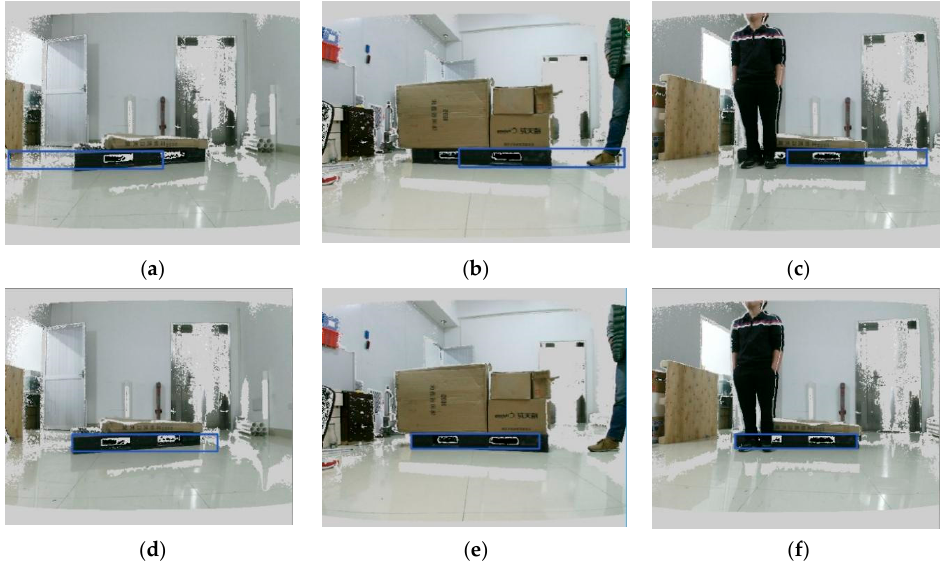
Figure 7. Comparison of experimental results under typical situations. The blue box represents the results of the recognition algorithm. ( a ) Recognition result with the template matching algorithm provided by OpenCV when the pallet angle was 15°. ( b ) Recognition result with the template match- ing algorithm provided by OpenCV when the pallet was subject to environmental influence. ( c ) Recognition result with template matching algorithm provided by OpenCV when the pallet was blocked by obstacles. ( d ) Recognition result with the proposed algorithm when the pallet angle was 15°. ( e ) Recognition result with the proposed algorithm when the pallet was subject to background disturbance. ( f ) Recognition result with the proposed algorithm when the pallet was blocked by obstacles. 4.2. Multiple Pallet Recognition The multiple pallet recognition results are shown in Figure 8, where red rectangles indicate the ROI of pallets marked by the algorithm. The precision and recall of the pro- posed method in this paper are 0.989, 0.926. Seventy-five pallets were recognized from eighty-one pallets. The precision and recall of the yolo v5 are 0.964, 0.986.